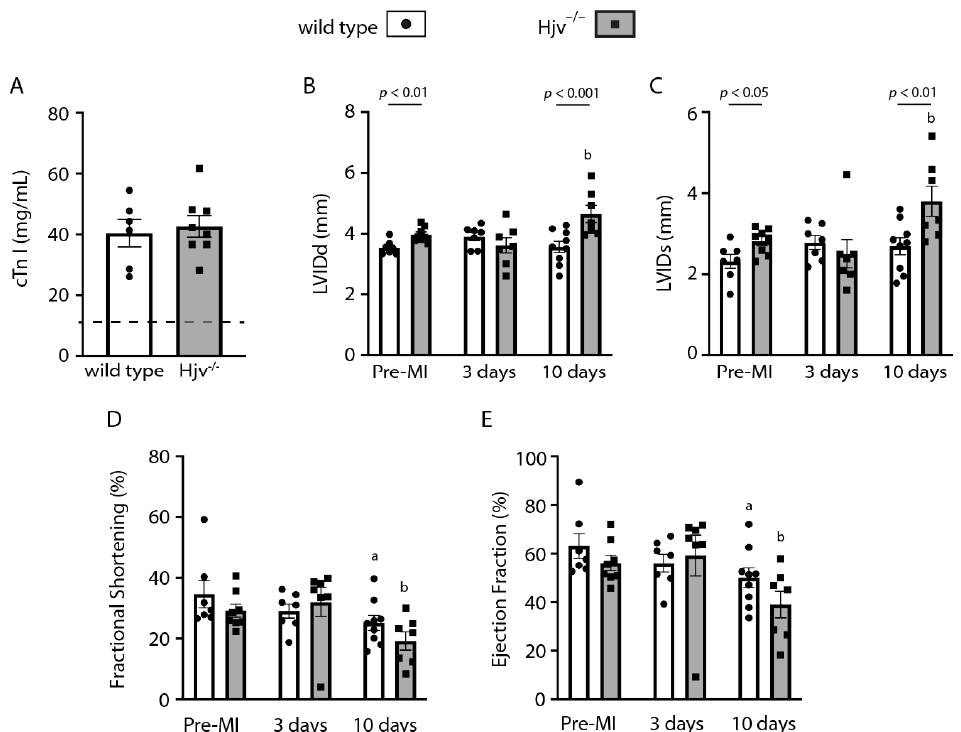
Figure 5. Hjv deficiency has minimal functional implications in the heart. Eleven-week-old male wild-type and isogenic Hjv − / − mice ( n = 7–9 per group) were subjected to myocardial infarction (MI) surgery. Echocardiography was performed in all animals before as well as 3 and 10 days after the procedure. ( A ) Plasma cardiac troponin (cTn I) levels 24 h after surgery; basal cTn I levels in both genotypes before surgery are indicated by a dotted line. ( B ) Left ventricular internal diameter end diastole (LVIDd); ( C ) left ventricular internal diameter end systole (LVIDs); ( D ) fractional shortening; ( E ) ejection fraction. Data are represented as mean ± SEM. Statistically significant differences ( p < 0.05) versus values from wild-type and Hjv − / − mice before surgery (pre-MI) are indicated by a and b , respectively.